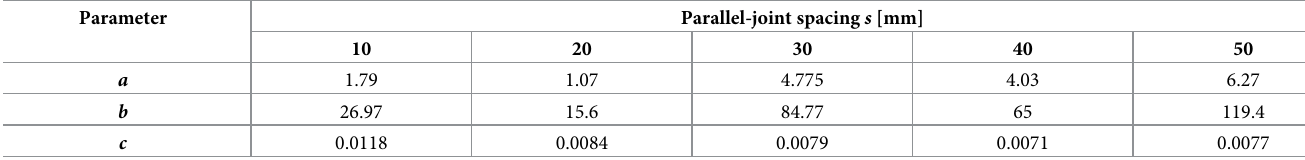
Table 5. Values of parameters a , b , and c .